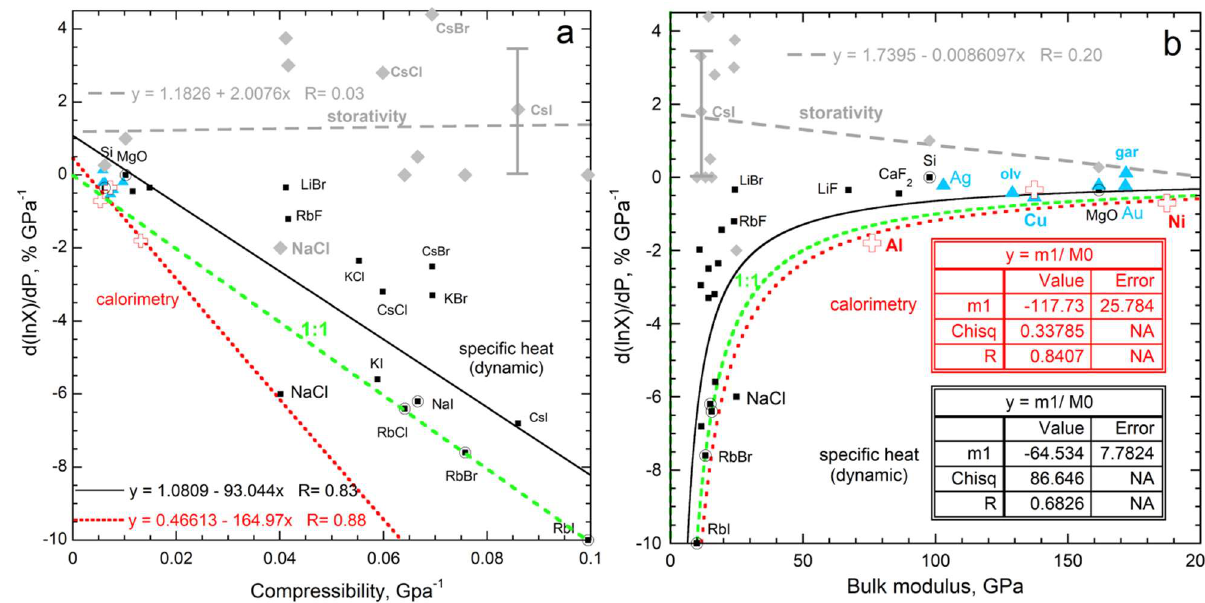
Figure 11. Graphs showing the response of storativity and c P to pressure: ( a ) dependence on the inverse of B ; ( b ) Direct dependence on B . Grey diamonds and grey dashed line = directly determined storativity: sources = [70–73] where the error bar is from Gerlich and Andersson [70]. Black squares and solid line = specific heat from C , where circles = data where C did not discernably depend on pressure. Open cross and red dotted line = metal c P directly measured by calorimetry [65,66]. Aqua triangles = heat capacity obtained by difference (sources: [69,74–78]). Green short dashed line = ideal correspondence.